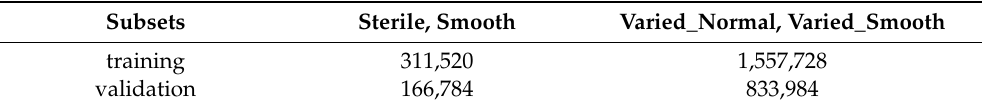
Table 3. The number of instances per each set in the training and validation datasets. The ‘varied_’ datasets have higher numbers because of additional variations to normal